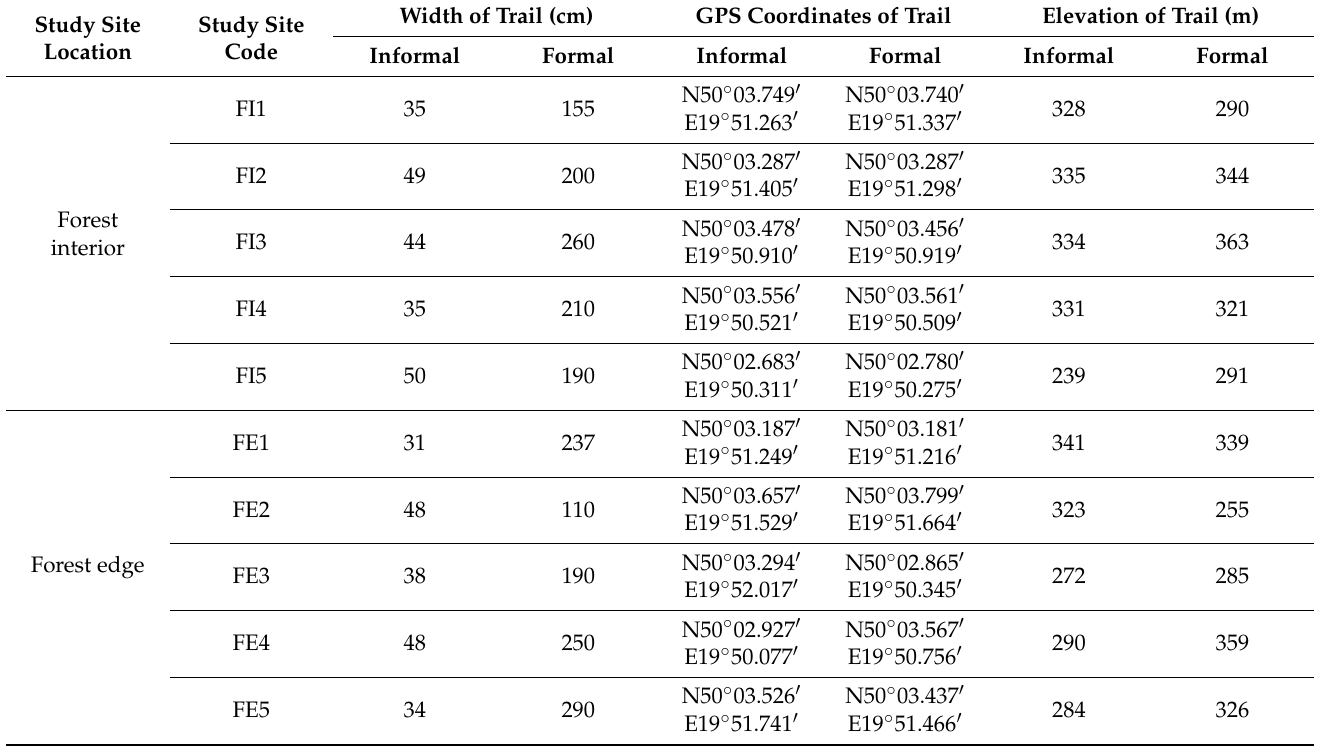
Table 1. The characteristics of study